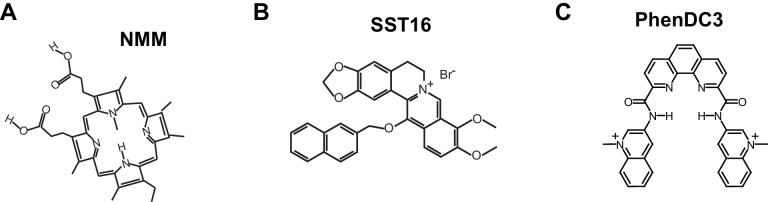
Structures of G4-stabilizing ligands used in this study.